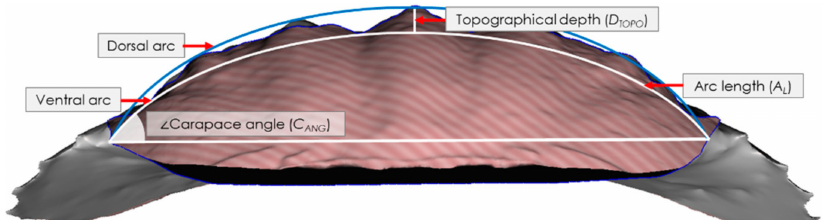
Figure 1. Intersecting arcs and lines used to determine the arc length, A L , the carapace angle, C ANG , and the topographical depth, D TOPO (maximum distance between the dorsal and ventral